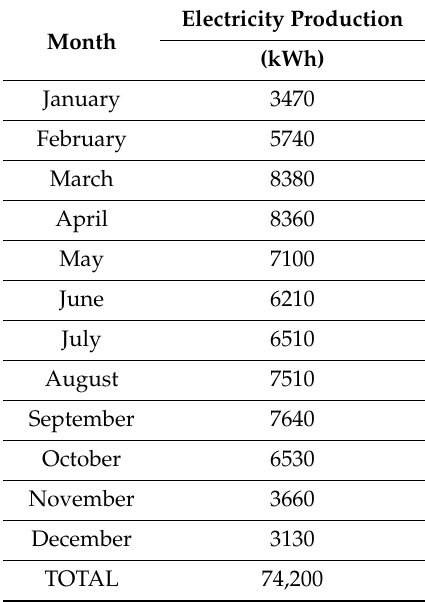
Table 1. Production of electricity from the planned PV installation located on the wall of the production